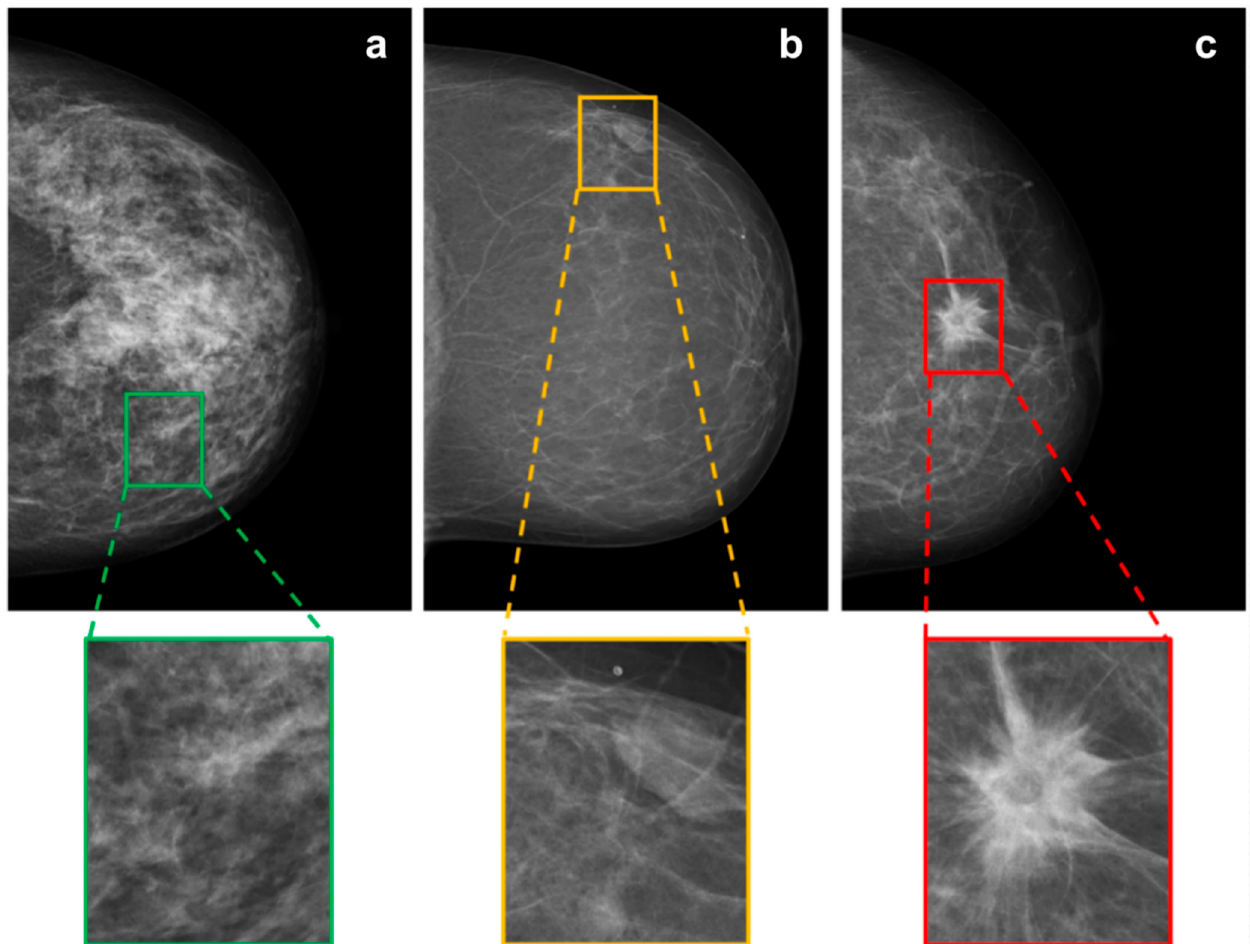
Figure 2. Mammographic illustrations of the three defined BI-RADS classes: ( a ) “healthy tissue”, ( b ) “probably benign soft tissue opacity” and ( c ) “suspicious soft tissue opacity”, with magnification of the ROI. Table 1. Number crops of mammograms used for training, validation and testing of the different dCNN models.